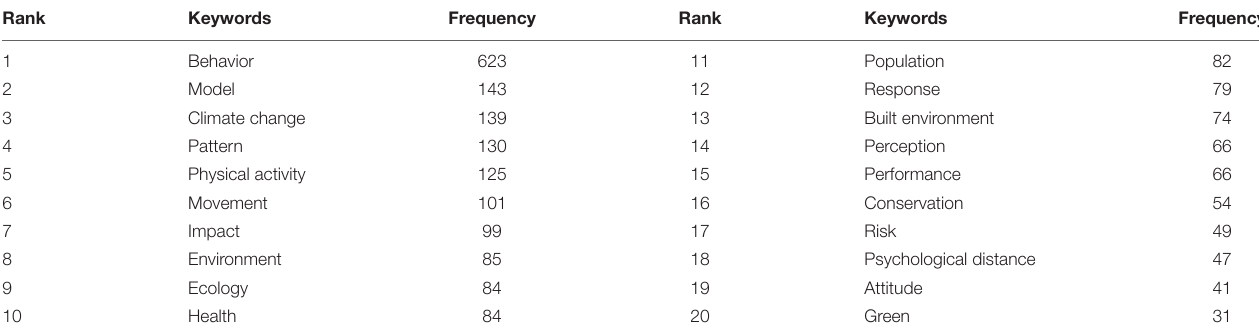
TABLE 3 | High-frequency keywords of literature on citizen environmental behavior (top